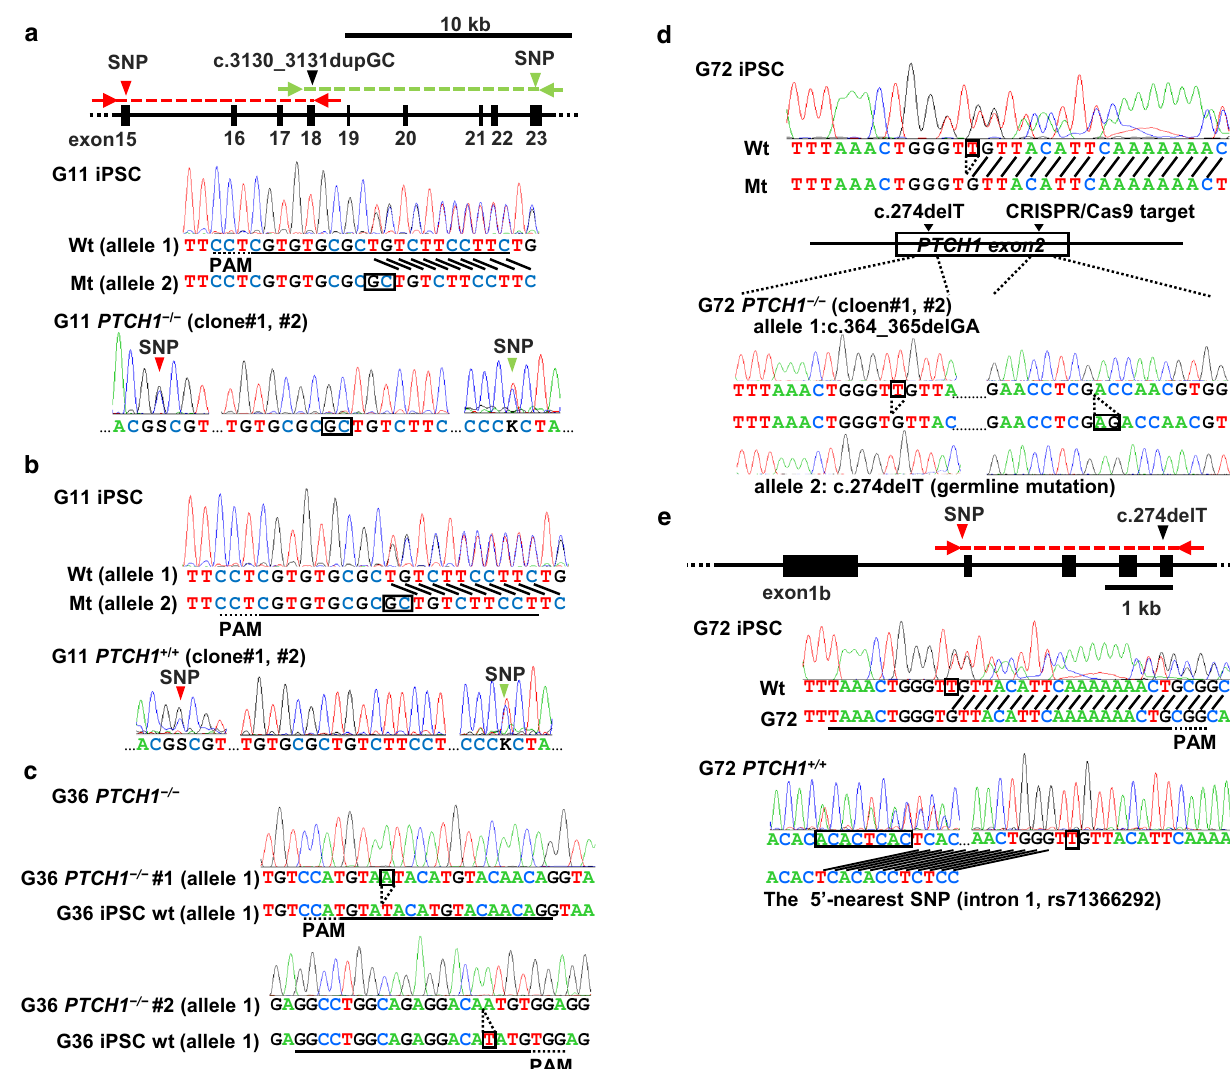
Fig. 1 Schematic presentation of PTCH1 -edited NBCCS iPSCs. a , b The disruption of the wild-type allele a and the correction of the mutated allele to the wild type b in G11-iPSC. The red and green arrowheads in the top panel indicate the locations of the nearest up- and down- stream SNPs, respectively. The red and green arrows indicate the positions of the primer pairs used for PCR direct sequencing. c The disrup- tion of the wild-type PTCH1 allele in G36-iPSC. Note that the entire PTCH1 on allele 2 was deleted in G36. d , e The disruption of the wild-type allele d and the correction of the mutated allele e in G72-iPSC. CRISPR/Cas9 target sequences and the protospacer adjacent motifs (PAM) were indicated by underlines and dotted underlines,